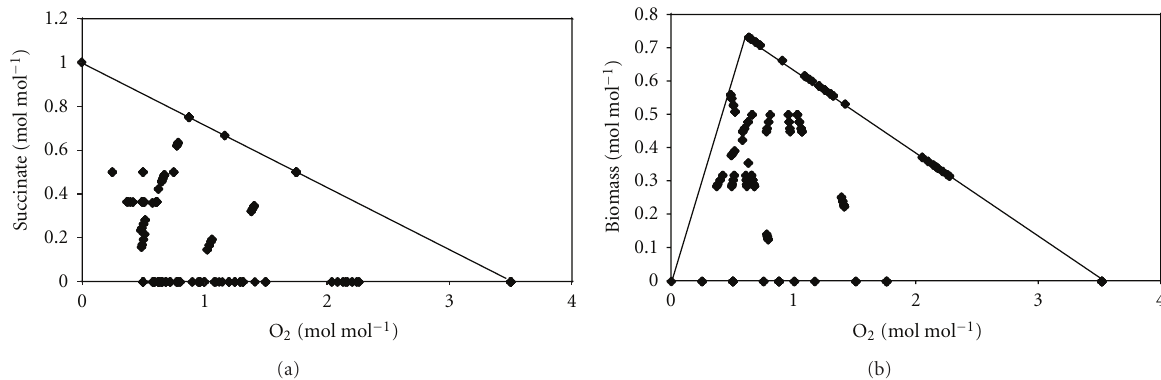
Figure 8: E ff ect of oxygen consumption on the succinate production and biomass formation under aerobic conditions. The enclosed regions represent the possible solution space. The fluxes were normalized by glycerol uptake rate and expressed as mol/mol